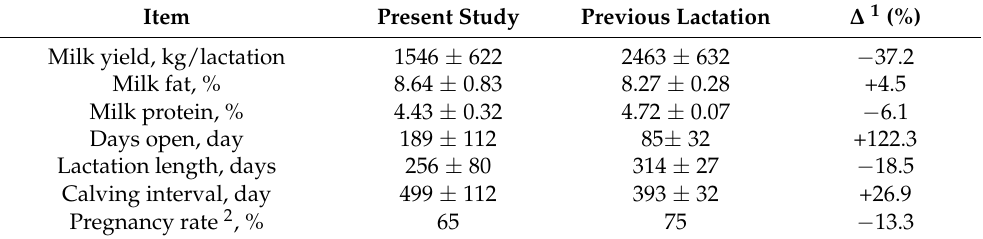
Table 6. Productive and reproductive performances (mean ± standard deviation) of lactating buffaloes.